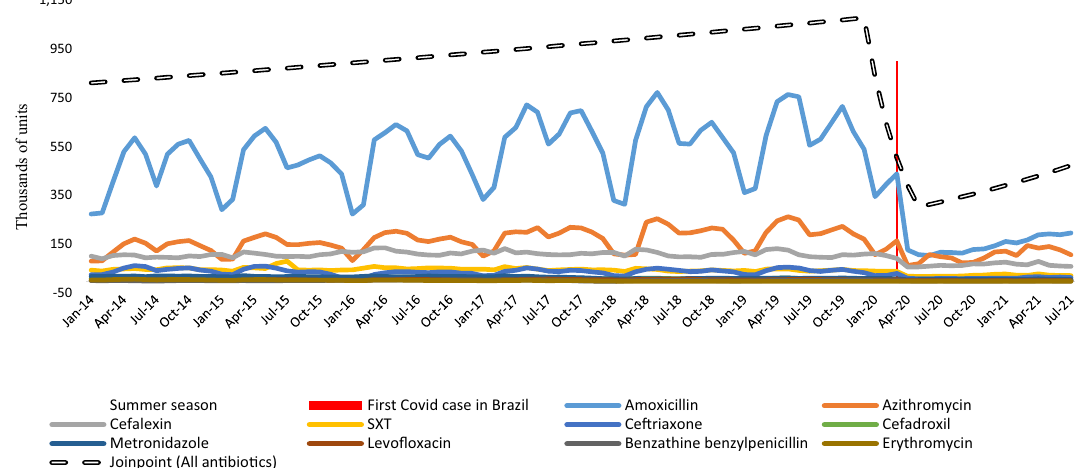
Figure 2. Monthly average of antibiotic sales (2014 Jan–2021 July), beginning of the pandemic in Brazil (red line), summer season (blue bars), and Joinpoint regression (dashed